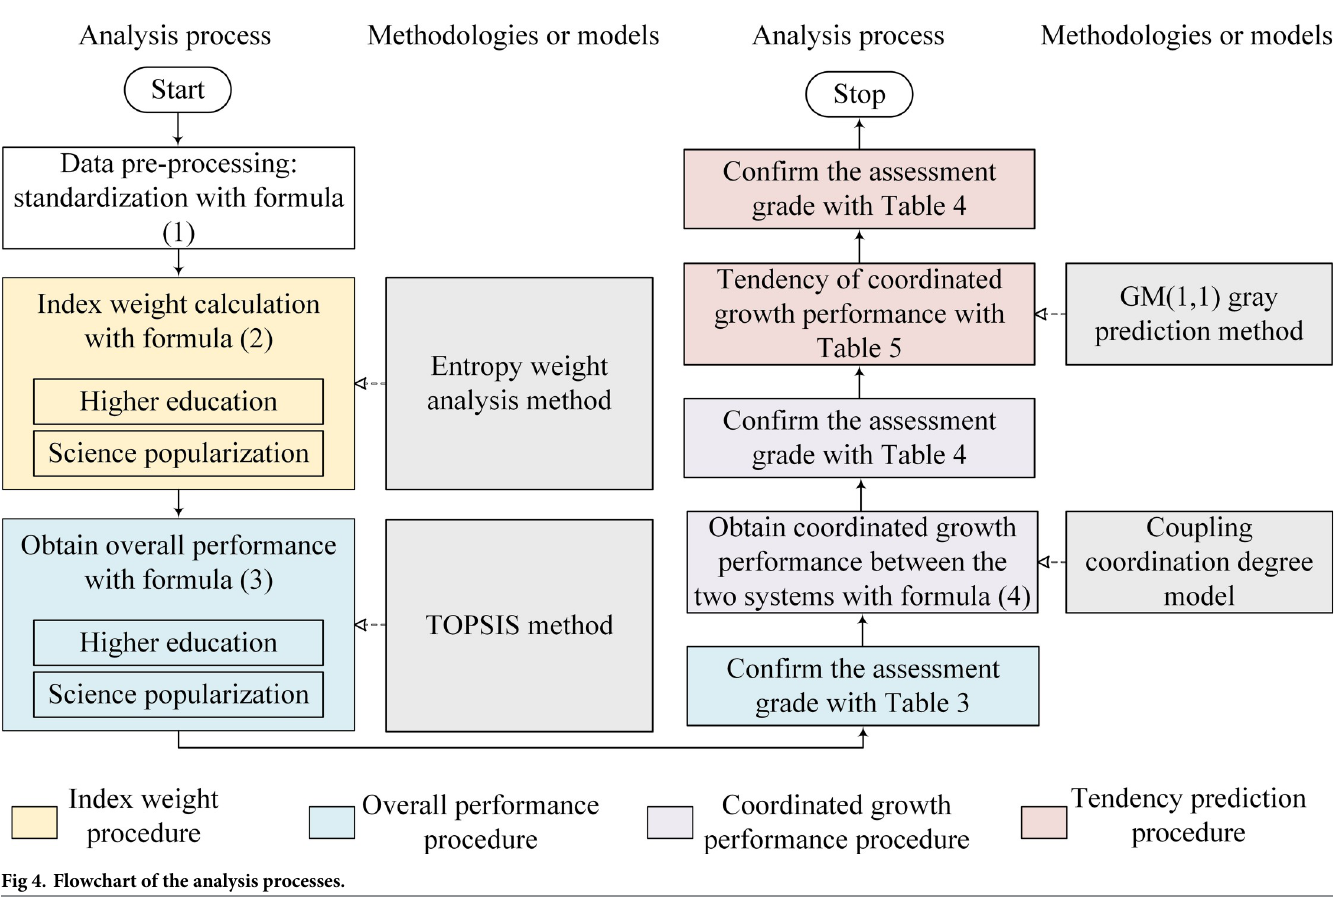
Fig 4. Flowchart of the analysis processes.